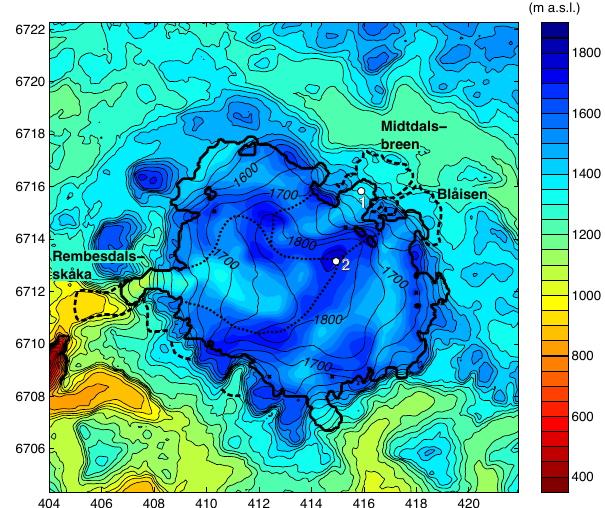
Fig. 2. Present-day surface topography (contours) and bedrock to- pography (colouring) in the model domain, contours are drawn ev- ery 50m. The thick solid lines indicate the present-day ice cap ex- tent, the thick dashed lines the reconstructed Little Ice Age mar- gin (references in text) and the dotted lines the drainage basins of Rembesdalsskåka and Midtdalsbreen. The locations of the AWSs on Midtdalsbreen (AWS1) and the ice cap summit (AWS2) are indicated by white dots and numbers. The reference system is UTM zone 32 (EUREF89), the tick mark spacing is